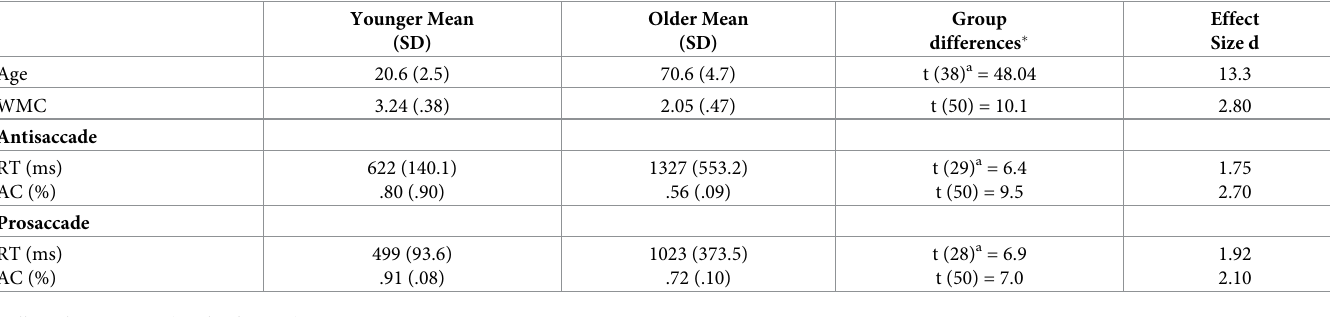
Table 4. Comparisons between younger and older